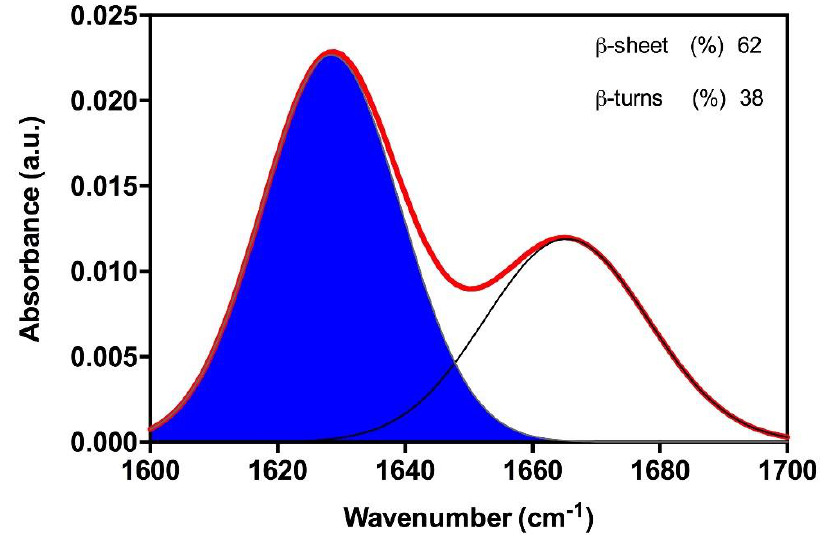
Figure 3. Amyloid core secondary structure of Hsf1. The secondary structure was determined from the Attenuated Total Reflectance (ATR) Fourier Transform Infrared (FT-IR) absorbance spectrum in the amide I region. The red line corresponds to the original spectrum; the blue area indicates the contribution of the inter-molecular β-sheet signal to the total area upon Gaussian deconvolution. Collectively, the data indicate that the predicted amyloid core of Hsf1 spontaneously self-assembles into highly ordered supramolecular structures highly enriched in β -sheet